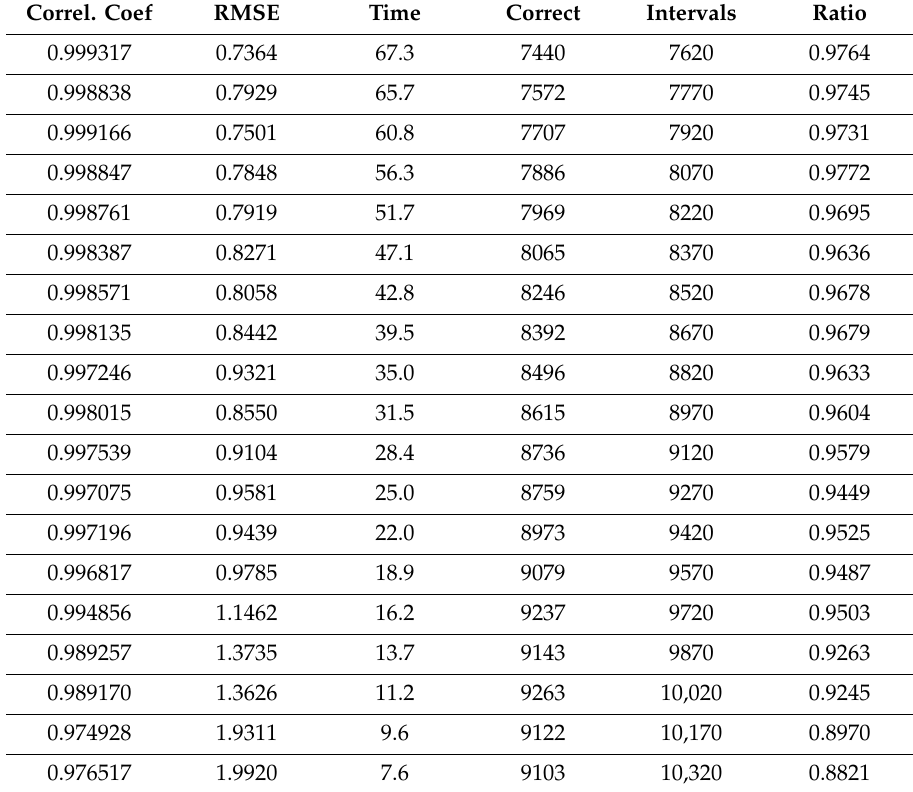
Table 3. Dependence of model precision (CorrelCoef, RMSE), calculation time (Time) and the success rate of 0.9 tolerance interval estimates (Ratio) on the number of records in the training set.